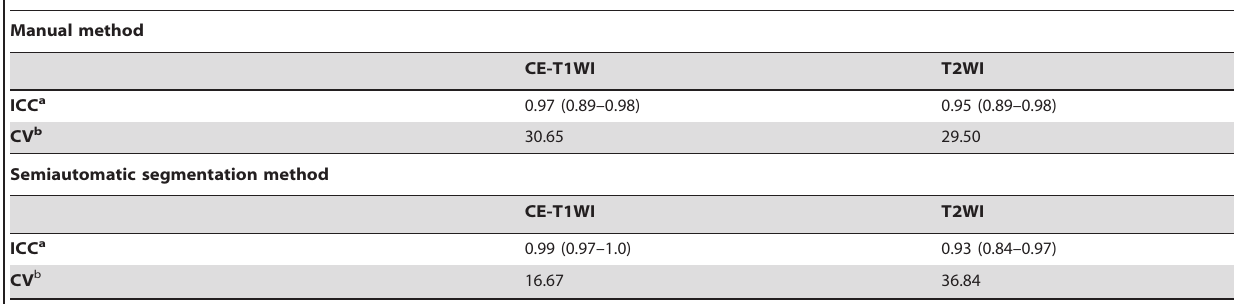
Table 4. Interobserver reproducibility of the mass volumes.